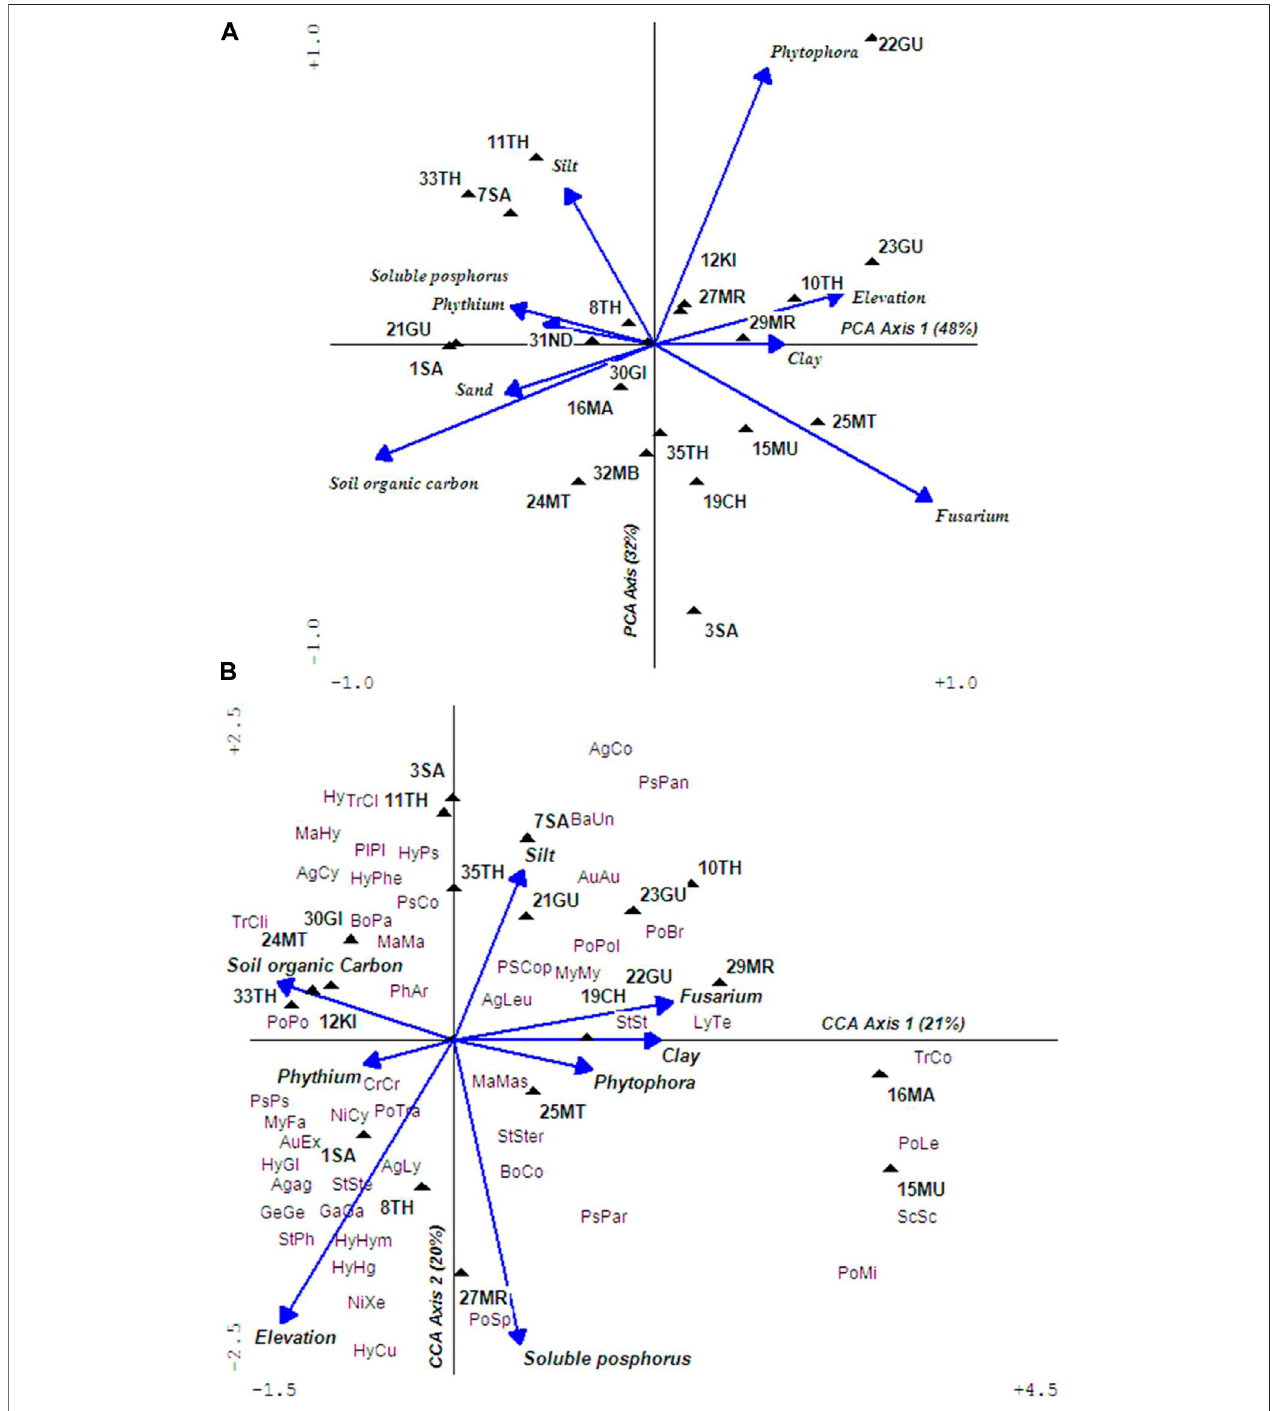
FIGURE 9 | Ordination plots of PCA (A) and CCA (B) showing ordination of sites according to environmental variables and species compositions in the UTR watershed. The abbreviated four-letter labels signify macrofungi with the fi rst two uppercase letters standing for family and the next two lowercase letters genus. Full taxon names are provided as Supplementary Table S4 . Soil parameters used to prepare PCA are provided as Supplementary Table S5 .